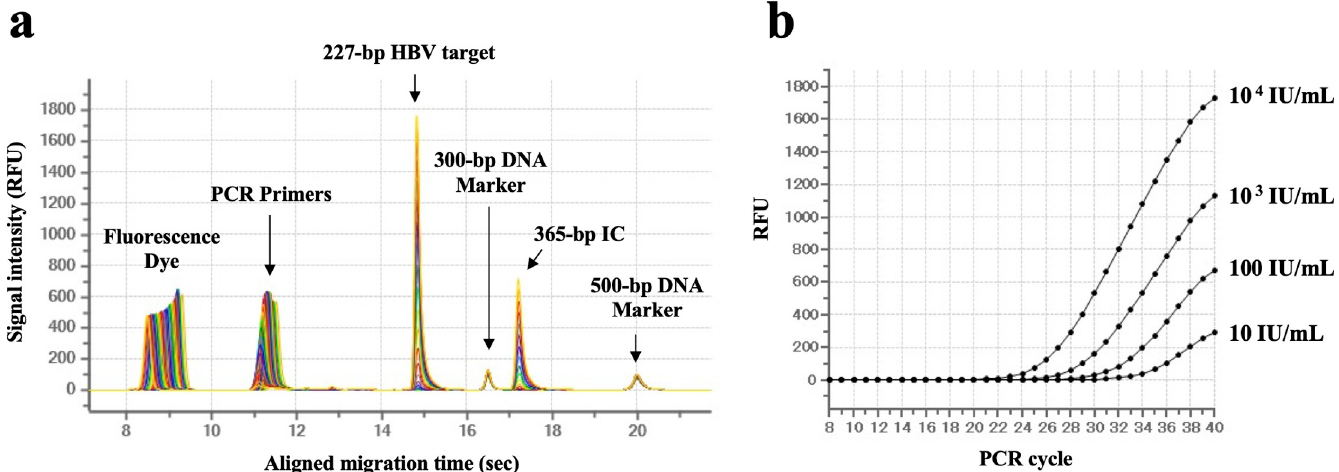
Fig 1. Real-time detection of HBV target using the μ TASWako g1 analyzer. (a) Overlay of electropherograms in the PCR-CE for 10 4 IU/mL of the 4 th WHO International Standard for HBV. Merged images of 33 electropherograms from 8 th to 40 th PCR cycle. (b) HBV amplification growth curves. RFU stands for relative fluorescence unit.